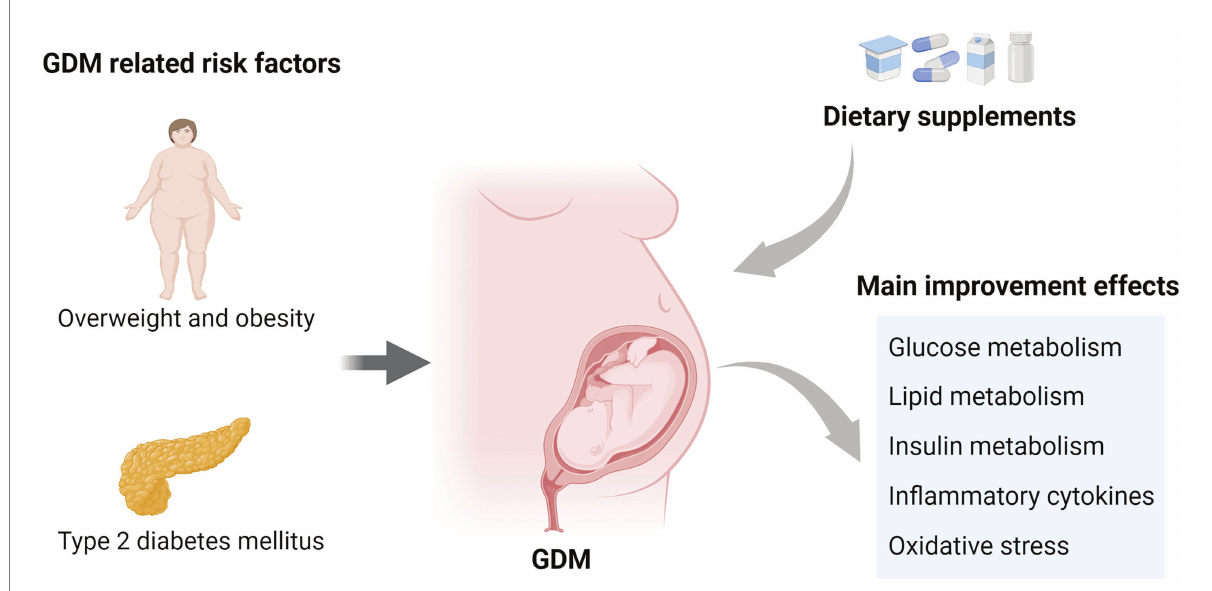
FIGURE 4 GDM related risk factors and the main improvement effects of dietary supplements on